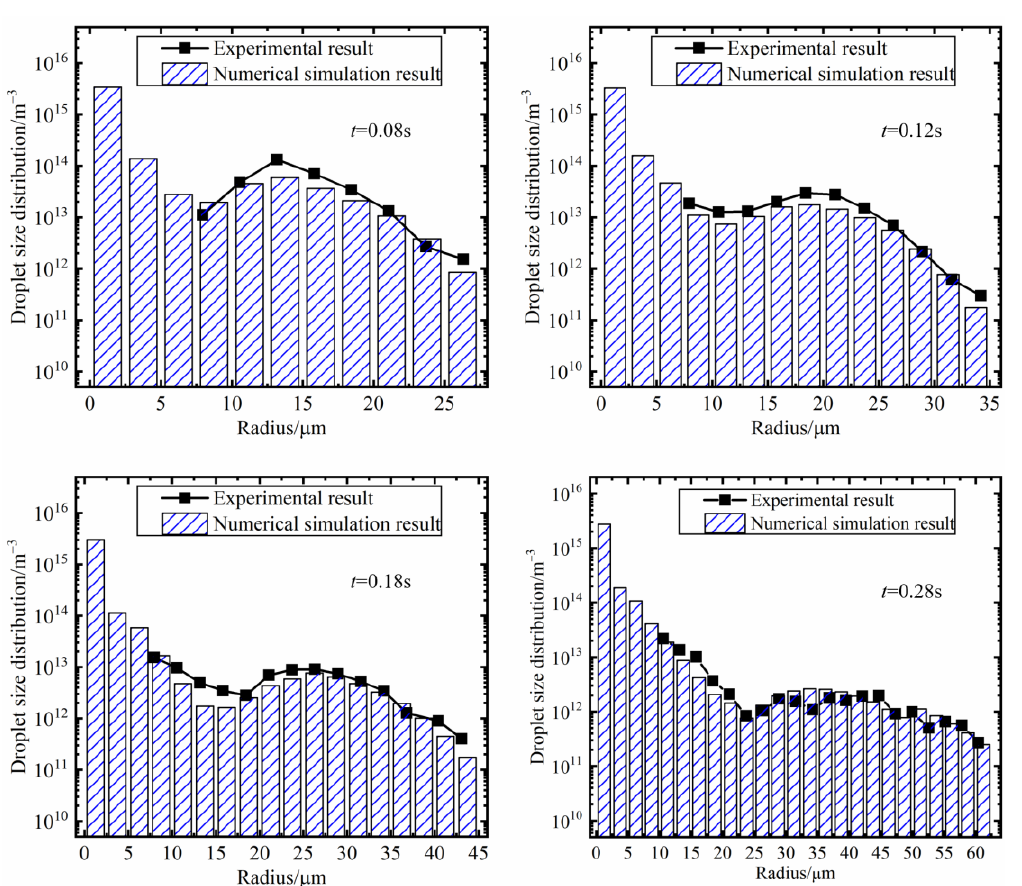
Figure 8. Comparison of droplet size distribution between numerical simulation and experiment [47].